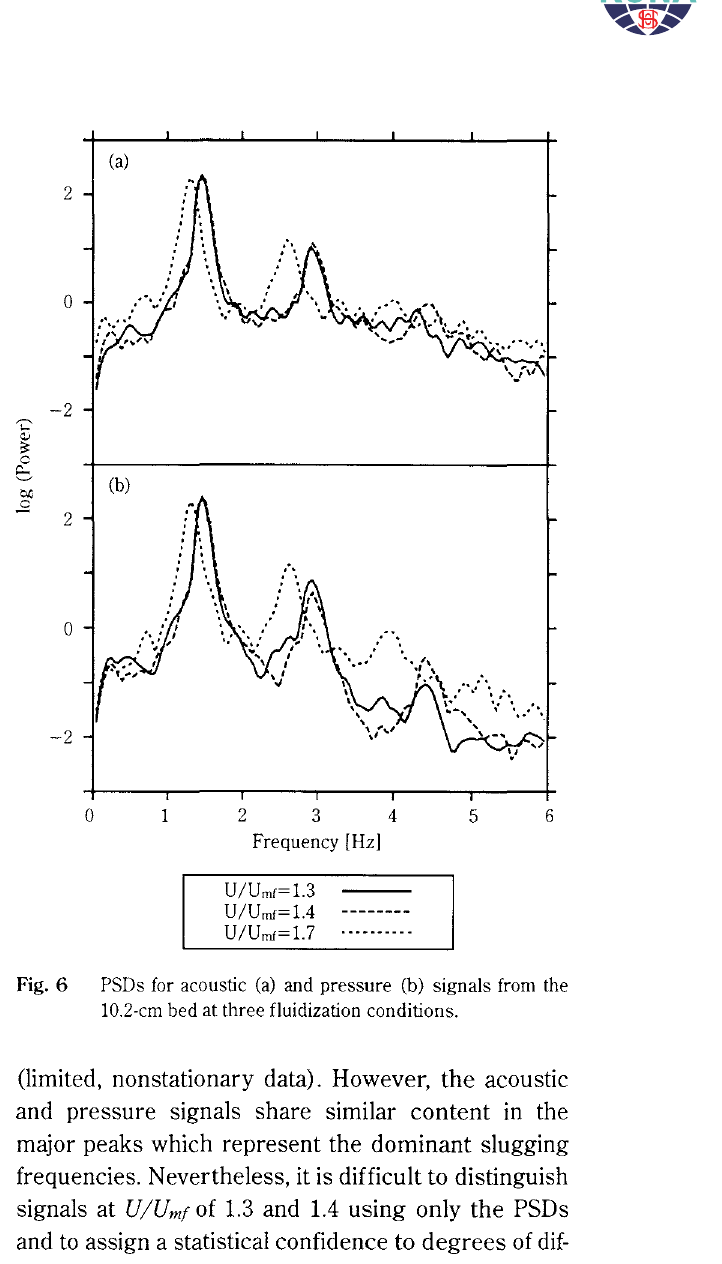
Fig. 6 PSDs for acoustic (a) and pressure (b) signals from the 10.2-cm bed at three fluidization